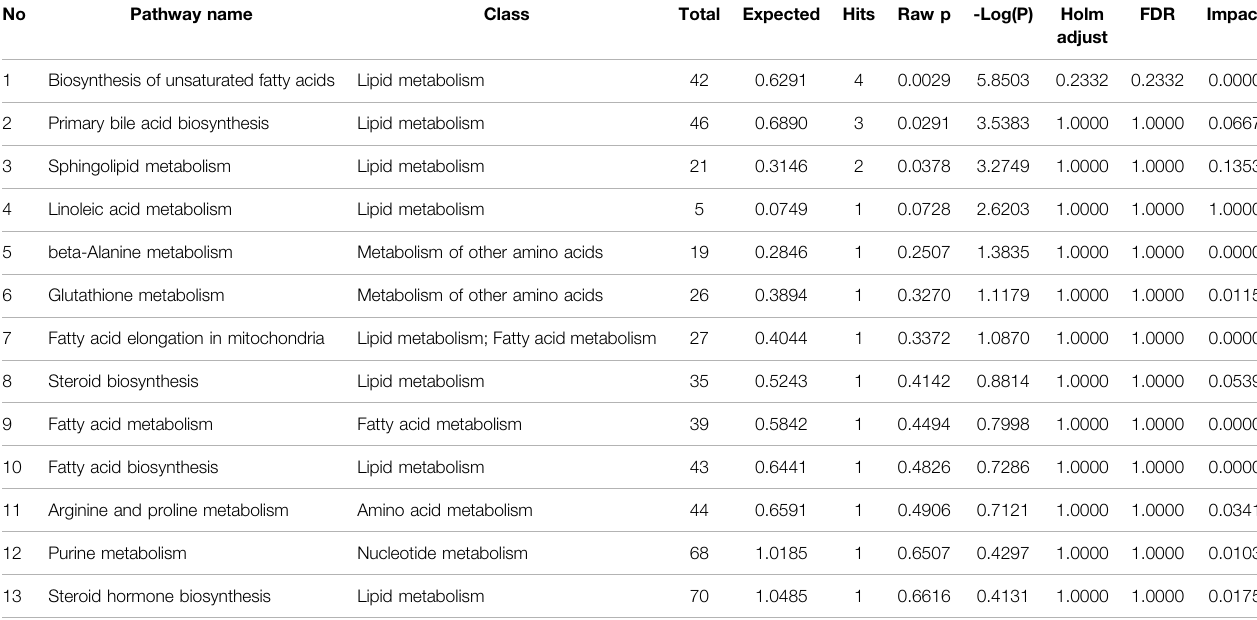
TABLE 3 | Metabolic pathway analysis based on